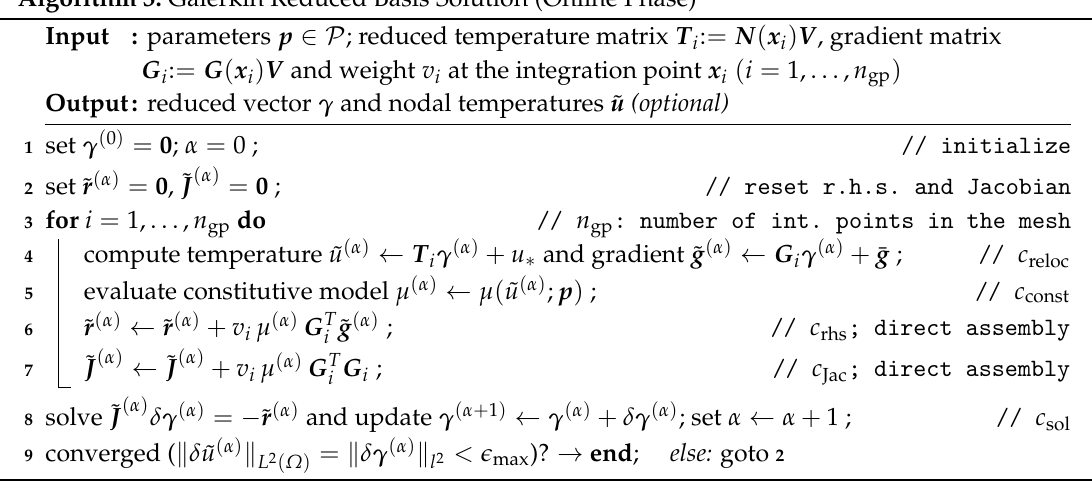
Algorithm 3: Galerkin Reduced Basis Solution (Online